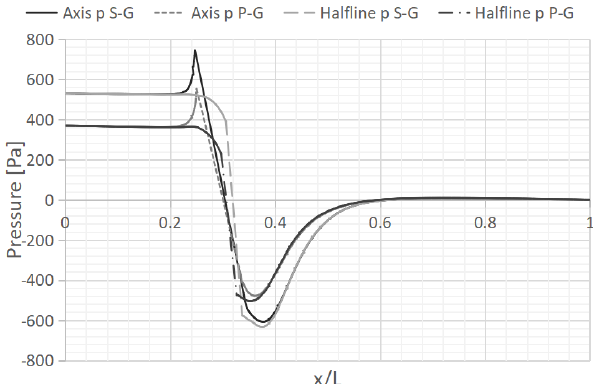
Figure 22. Relative pressure along the axial